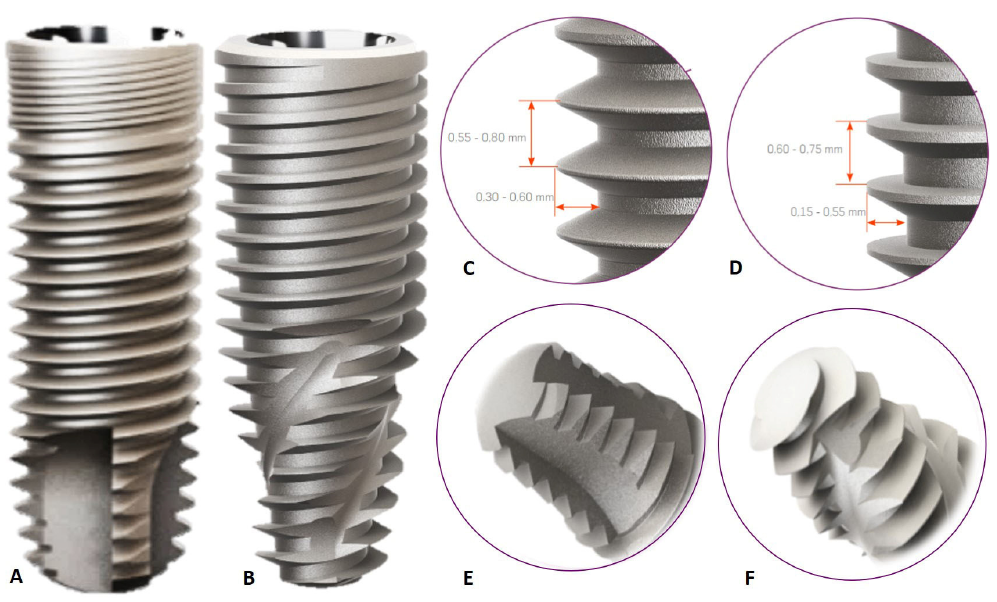
Figure 1. Macrostructure of implants installed in the cortical bone of rabbits. Body ( A ), threads ( C ) and apex ( E ) of the Cylindrical Implant; Body ( B ), threads ( D ) and apex ( F ) of the Hybrid Conical Implant.